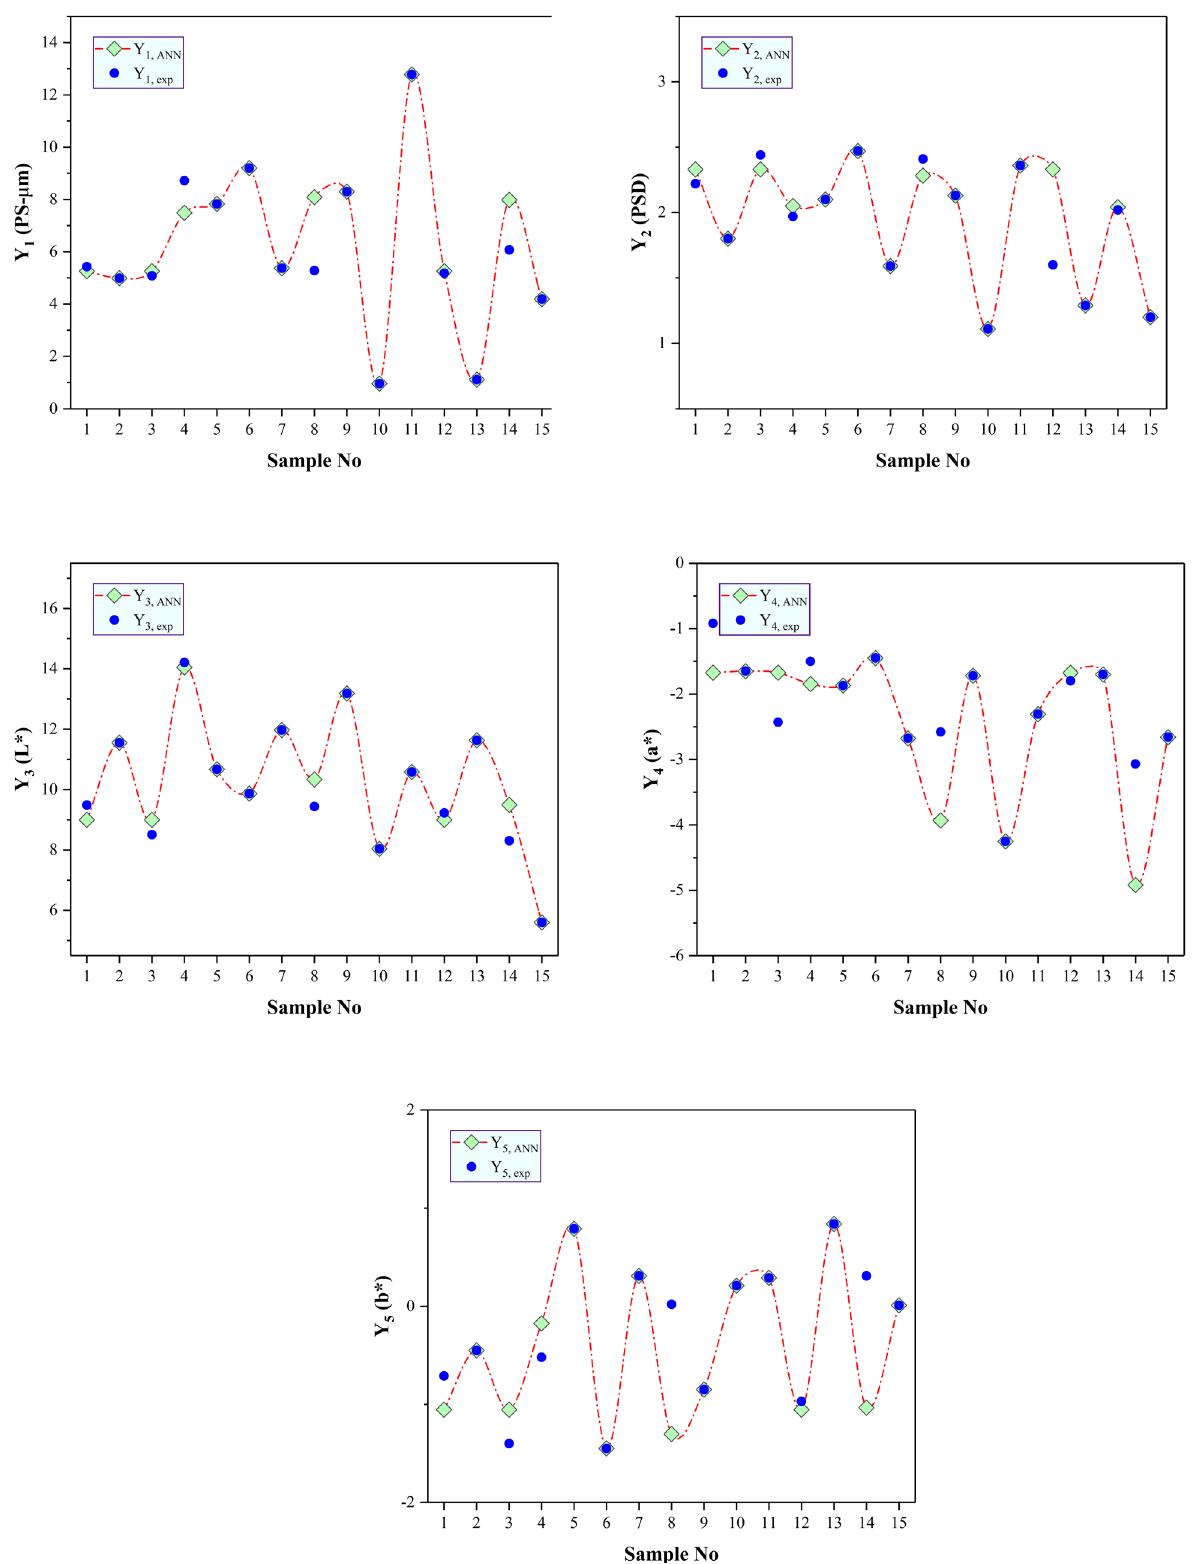
Figure 6: Comparison of the experimental with predicted values corresponding to PS, PSD, and color (L*, a*,